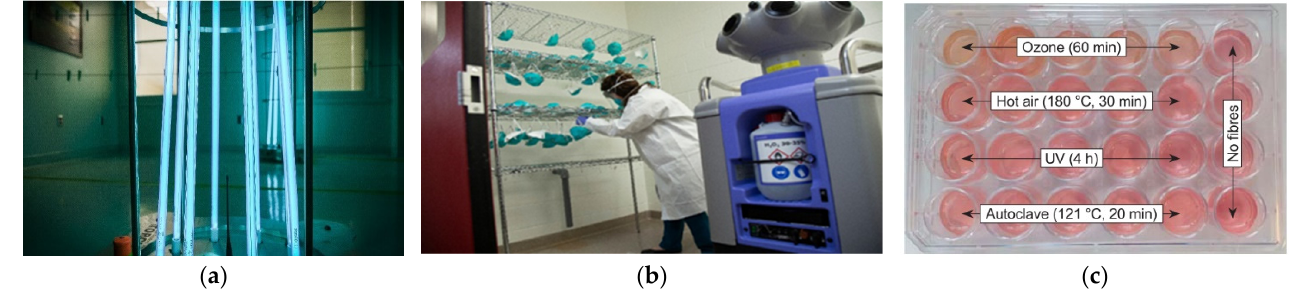
Figure 8. ( a ) UV radiation to N95 mask at University of Nebraska and ( b ) Hydrogen peroxide vapor generator at Duke University Hospital [120], and ( c ) Sterilization conditions [119].